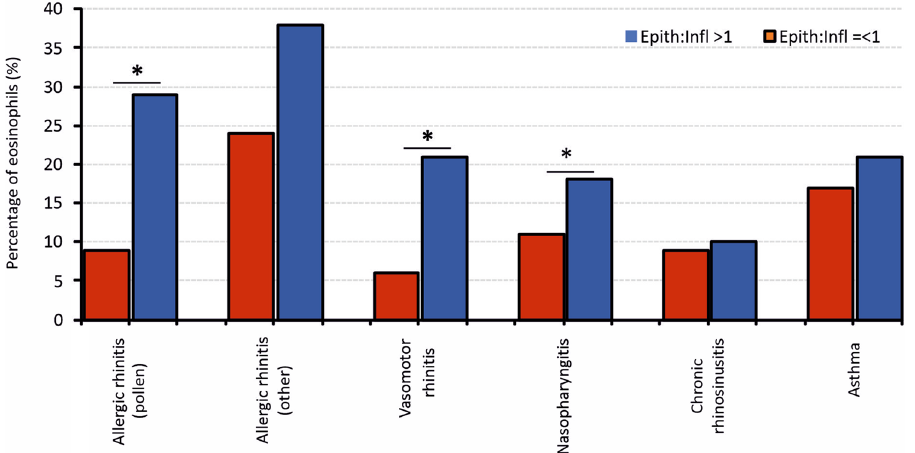
Figure 3. The percentage of eosinophils in the group of inflammatory cells, in patients with/without the signs of inflammation, taking into account the diagnosis. Statistically significant differences were marked (*p < 0.05).